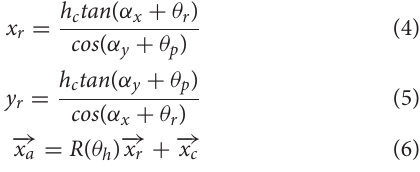
pixels (8, 688 × 5, 792), and f is the focal length of the lens (17–21